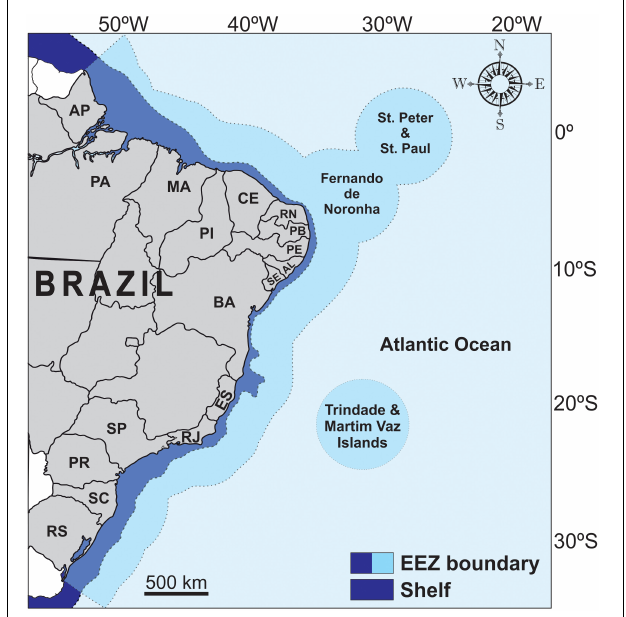
FIGURE 1 | Brazilian coastal states, from Amapá (AP), in the north, to Rio Grande do Sul (RS), in the south. The Brazilian Exclusive Economic Zone (EEZ) and continental shelf waters (to 200 m depth) are also shown. PA = Pará, MA = Maranhão, PI = Piauí, CE = Ceará, RN = Rio Grande do Norte, PB = Paraíba, PE = Pernambuco, AL = Alagoas, SE = Sergipe, BA = Bahia, ES = Espírito Santo, RJ = Rio de Janeiro, SP = São Paulo, PR = Paraná, SC = Santa